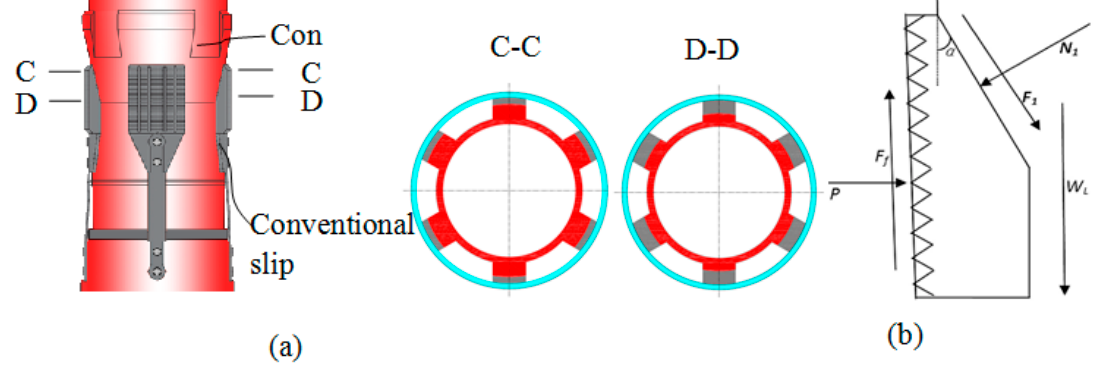
Figure 3. Conventional liner hanger profile. ( a ) Prototype model of slips and cone; ( b ) the forces acted on the slip.